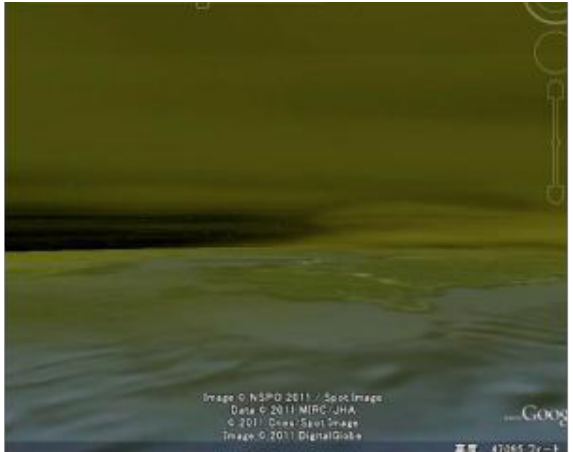
Fig. 9 Asian dust cloud covering the sky in the case that we are in the dust